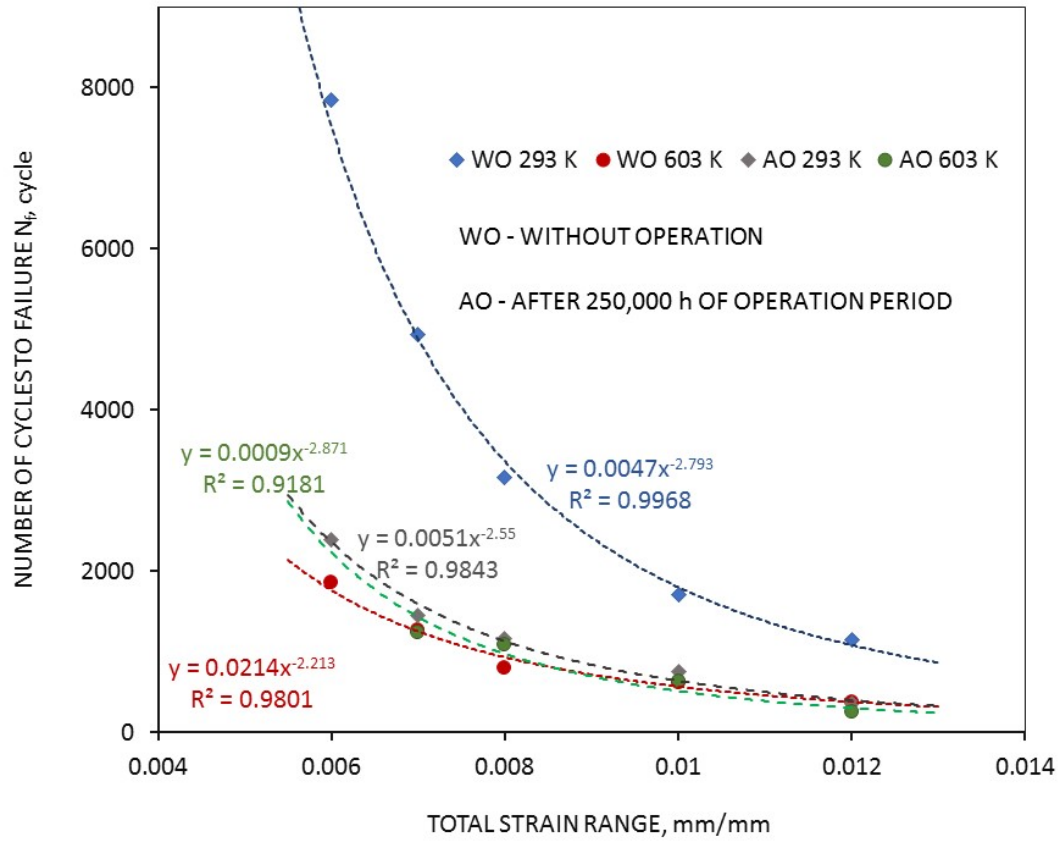
Figure 14. Fatigue curves of the number of cycles to failure (N f in Table 1) versus total strain range ( ∆ ε c ), for the entire population of materials tested .